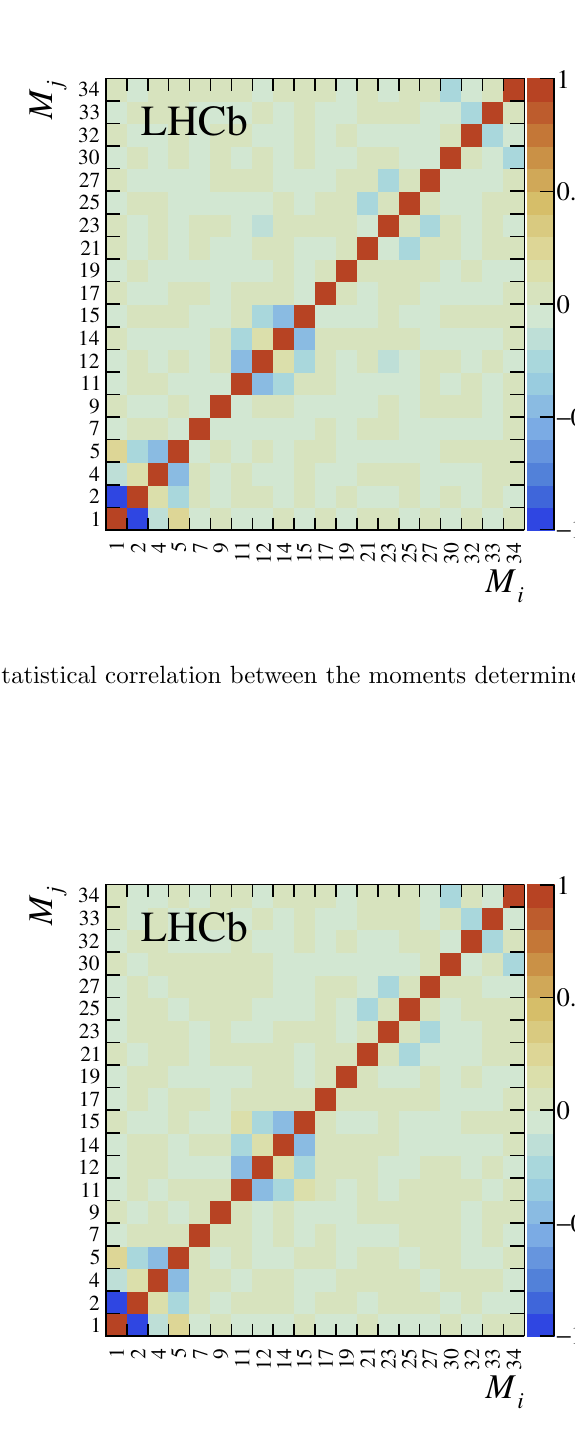
Figure 10 . Statistical correlation between the moments determined at